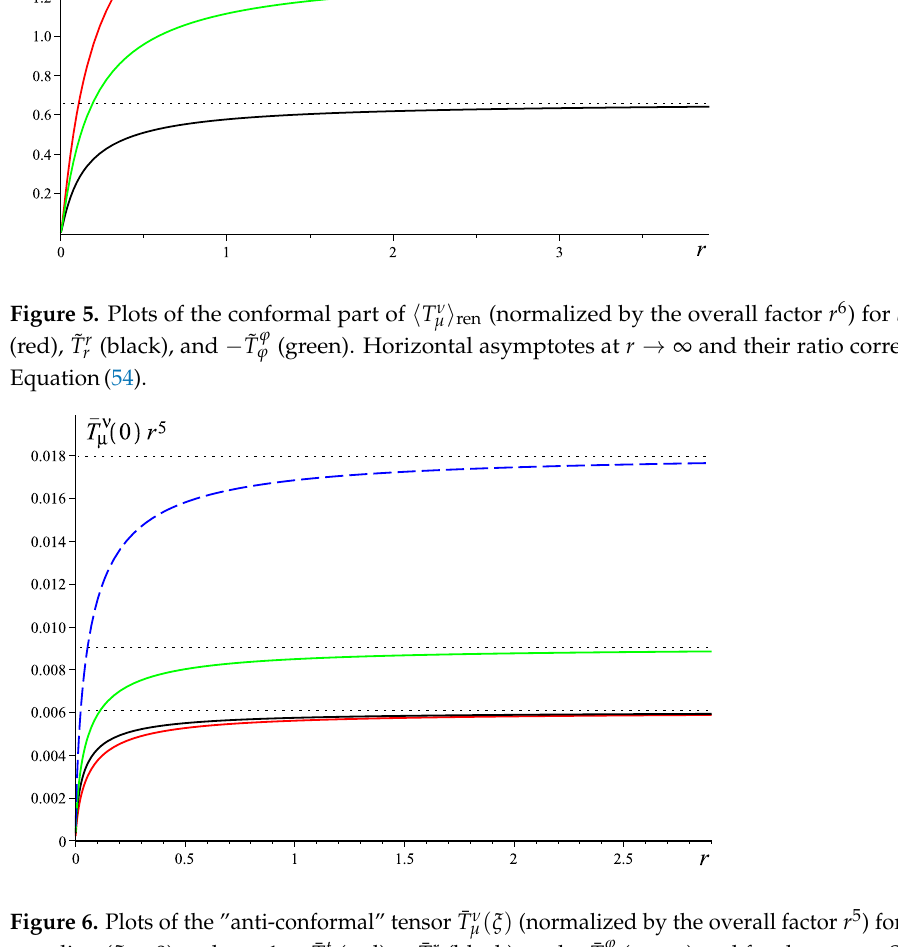
Figure 6. Plots of the ”anti-conformal” tensor ¯ T ν µ ( ξ ) (normalized by the overall factor r 5 ) for minimal coupling ( ξ = 0) and α = 1: − ¯ T t (red), + ¯ T r r (black), and − ¯ T ϕ ϕ (green) and for the trace − Sp ¯ T (blue t dashed). Horizontal asymptotes at r → ∞ and their ratio correspond to Equation(53). The ratio Sp ¯ T / ¯ T t asymptotically corresponds to t